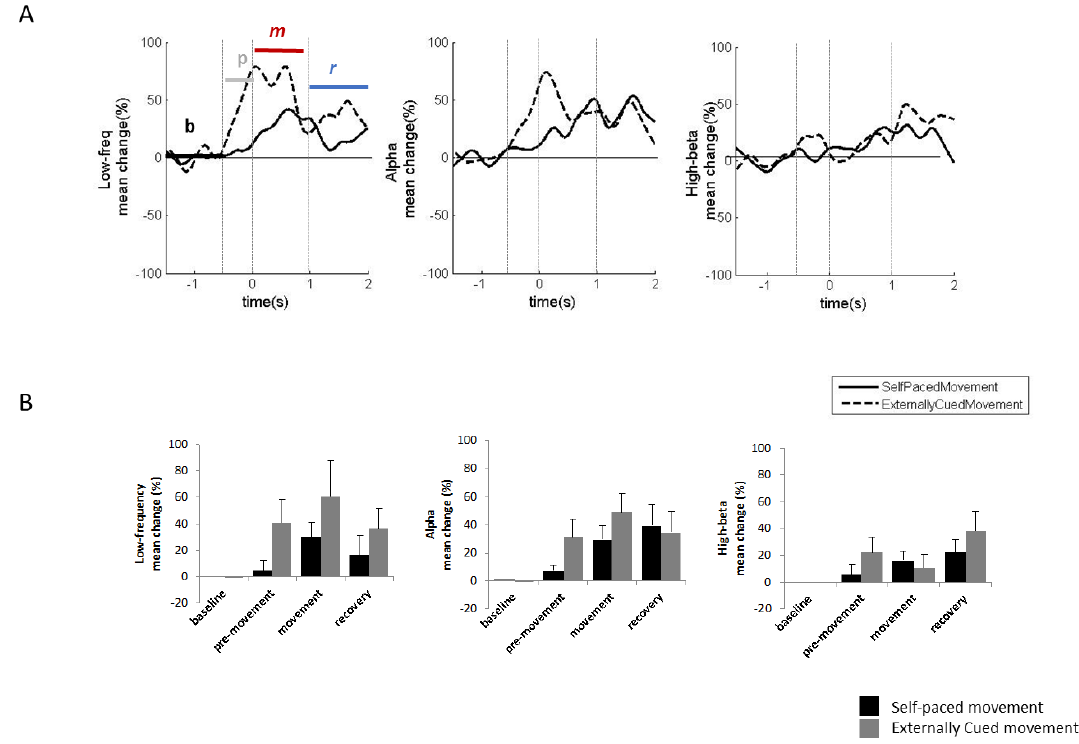
Figure 2. Vo/CM-Pf LFP power modulation during voluntary movements. ( A ) Grand average ( n = 7) of the low-frequency ( left plot ), alpha ( central plot ), and high beta ( right plot ) power modulations during self-paced voluntary movements (solid black line) and externally-cued movements (dashed black line). Power modulations are expressed as percentage changes from the baseline phase and were estimated starting from 1.5 s before the movement onset until 2 s after the movement onset. The four movement-related phases were baseline (b), pre-movement (p), movement (m), and recovery (r). x -axis: time (s); y -axis: Hilbert-power modulations (Percentage). ( B ) The histograms represent the mean power modulation for low-frequency ( left plot ), alpha ( central plot ), and high beta ( right plot ) bands in the four movement phases (baseline, pre-movement, movement, and recovery) for self-paced movements (black bars) and externally-cued movements (grey bars). Error bars represent the standard error. Table 2. Summary of average LFP modulations observed in the Vo/CM-Pf thalamic nucleus during voluntary and involuntary movements in the low-frequency (2–7 Hz) and alpha (8–13 Hz) bands in patients with